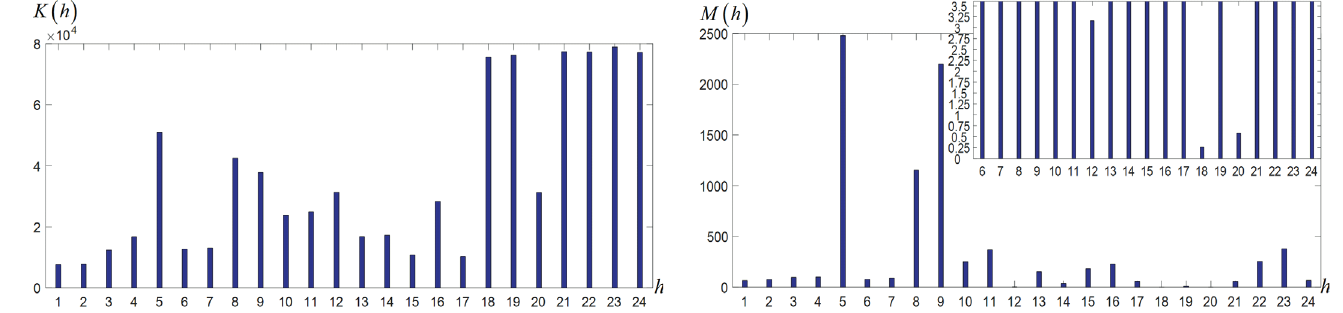
Fig. 7. Distribution of number K ( h ) for the case with (24). Fig. 8. Distribution of number M ( h ) for the case with (24).